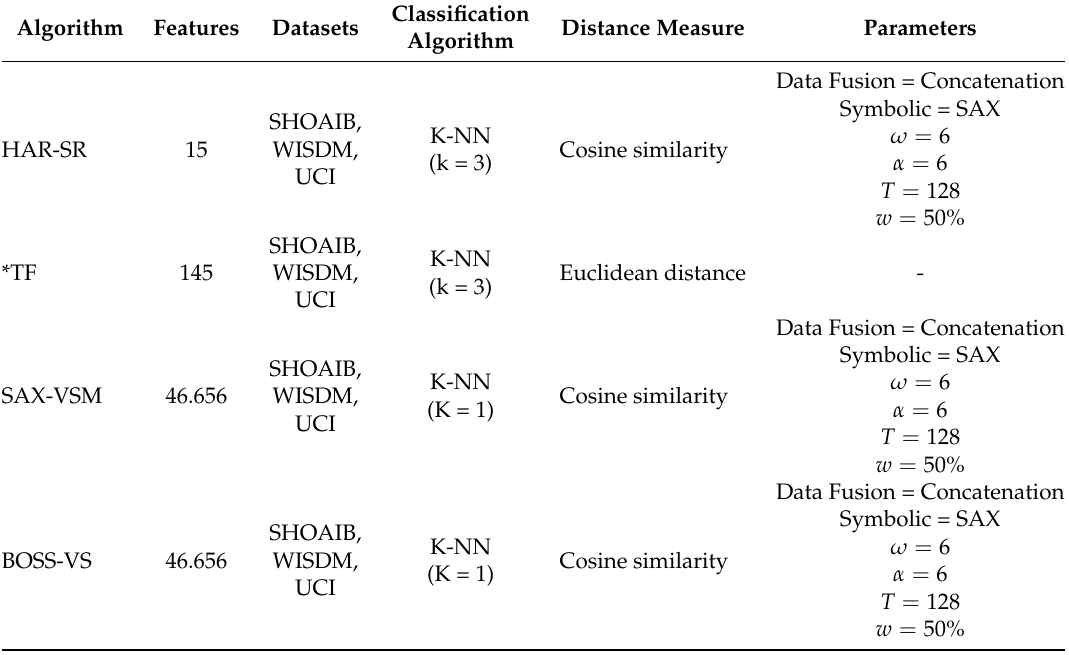
Table 6. The parameters used in HAR-SR, TF, SAX-VSM, and BOSS-VS algorithms. *TF is a classification method that uses time and frequency domain